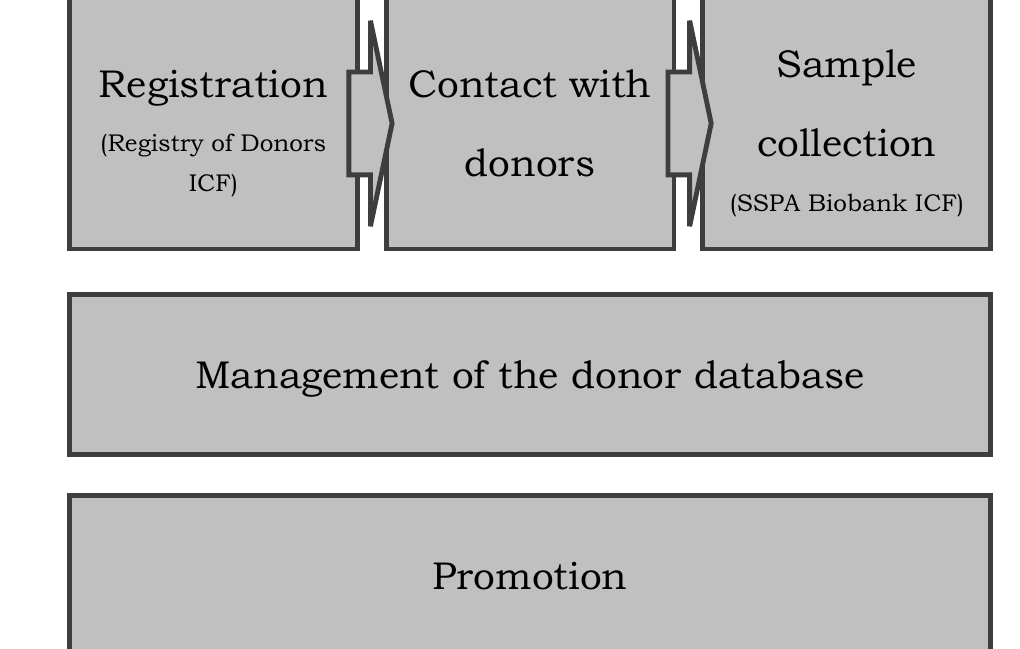
Figure 1. Main processes of the operation of the Andalusian Registry of Donors for Biomedical Research. ICF, informed consent form.